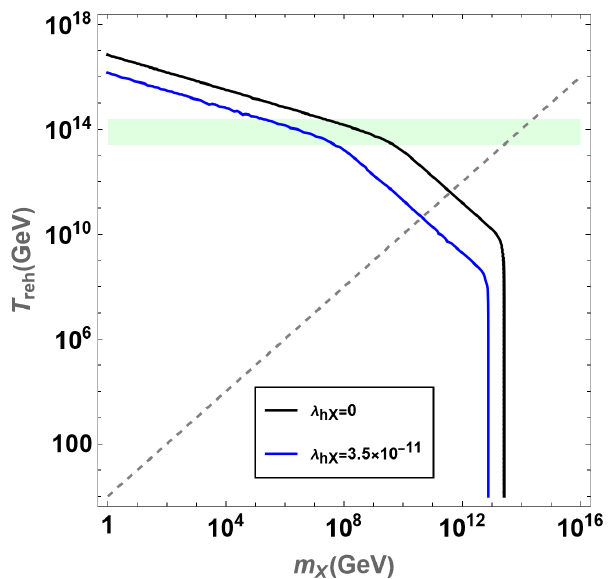
Figure 7 . The same figure as figure 6, but the case with a nonzero Higgs-portal coupling, λ hX = 3 . 5 × 10 − 11 , is included in blue